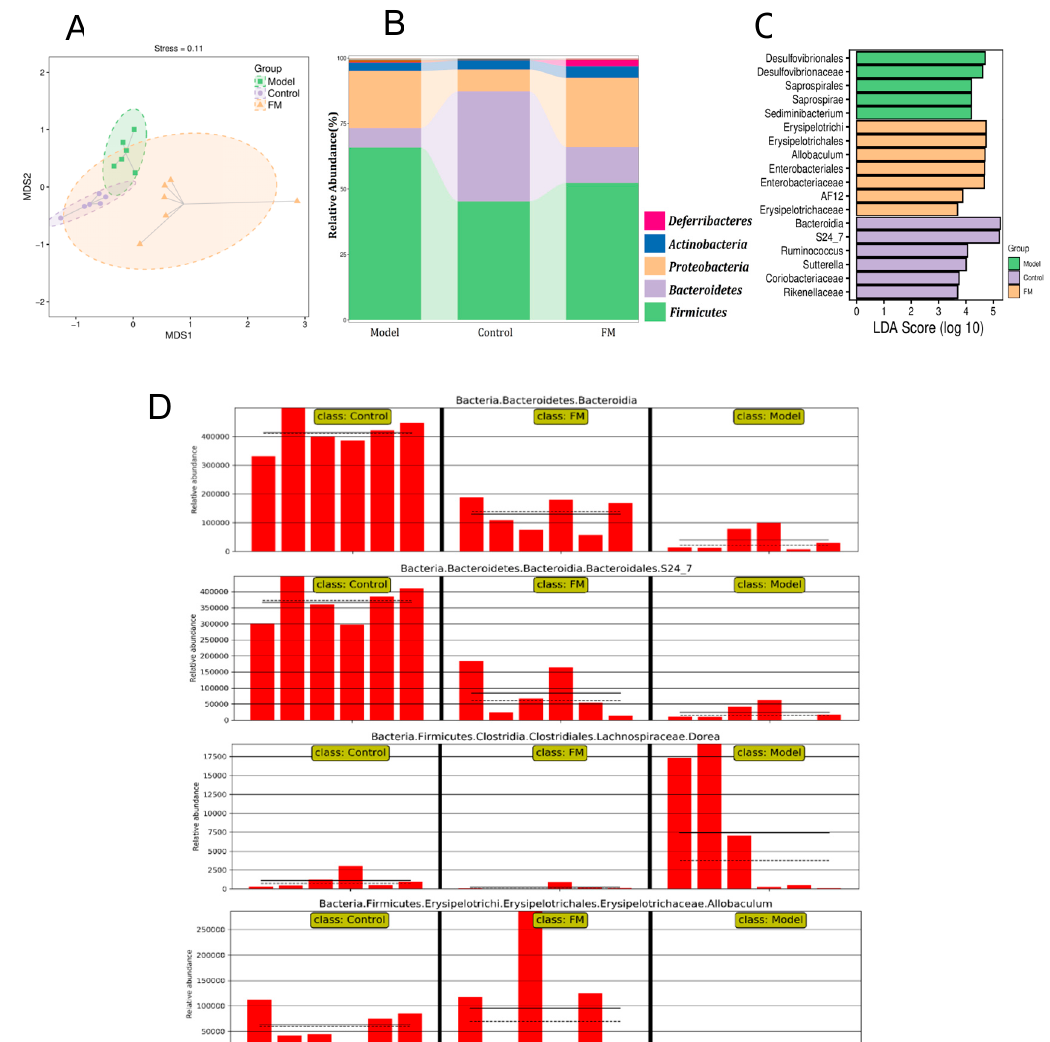
Figure 7. The NMDS analysis ( A ), the relative abundance (%) of bacterial at phylum level in different groups ( B ), the significantly different species in three groups ( C ) and the relative abundance the of gut microbial biomarkers in three groups ( D ).